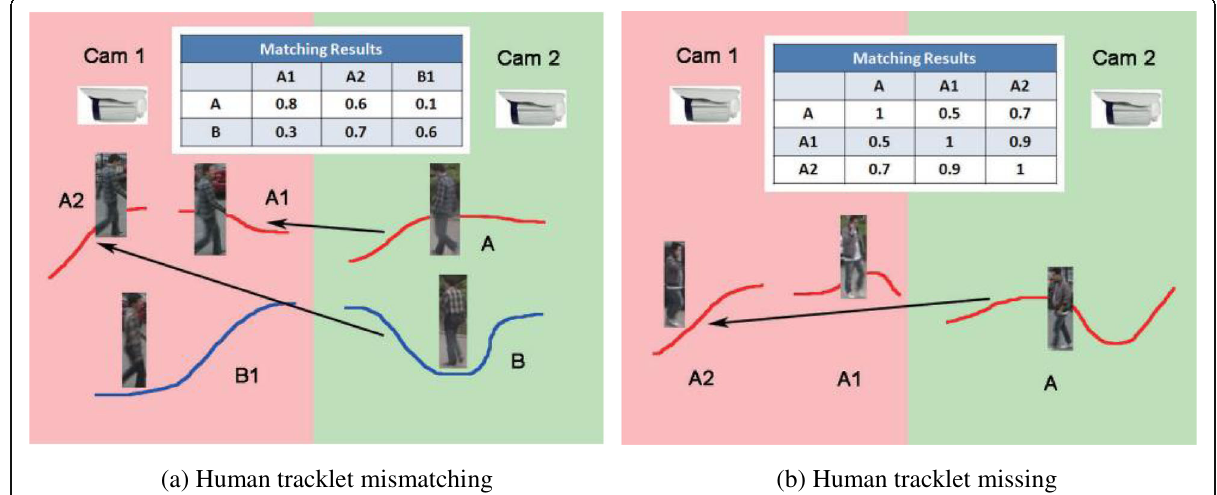
Fig. 15 Illustration for human tracklet mismatching and missing. Blue and red lines indicate two human targets, and arrows show the best matching. Human target B is mismatched to human tracklet A2 in ( a ). Human tracklet A1 is missing in ( b ) [62]